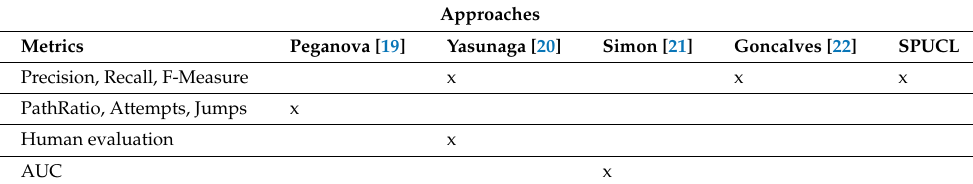
Table 6. Comparison between SPUCL and the other approaches’ evaluation